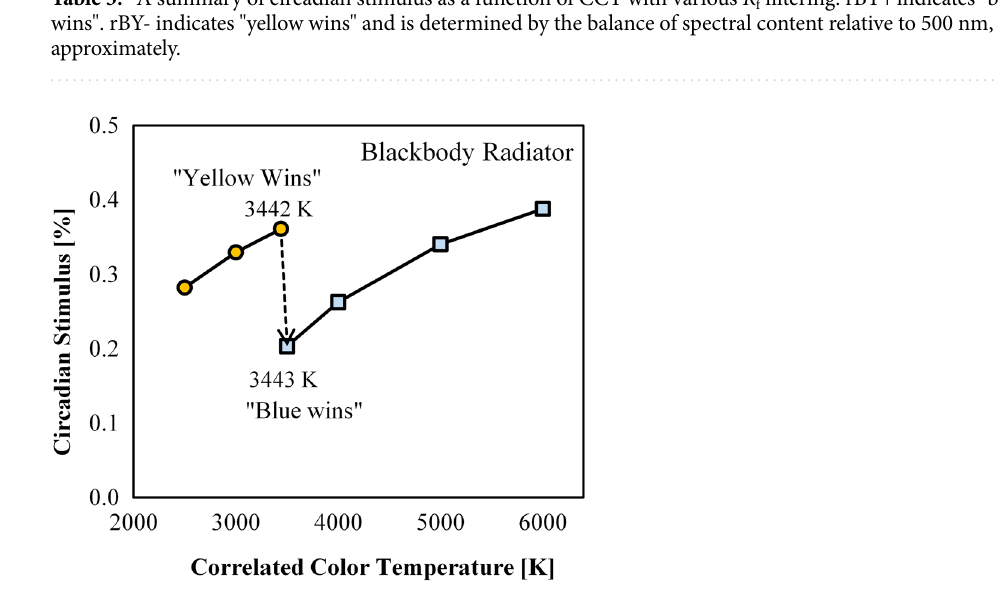
Figure 9. Circadian Stimulus (CS) as a function of CCT for a blackbody radiator. The exact inflection point of the b-y spectral opponency of the CS model for a blackbody radiator occurs between 3442 and 3443 K. Up to 3442 K, “yellow wins” (indicated by circle markers); from 3443 K onwards, “blue wins” (indicated by square markers). The dashed line indicates the transition point of the model and is dashed to indicate that this transition is not continuous (values along this line are not achievable) and that the CS model is a step